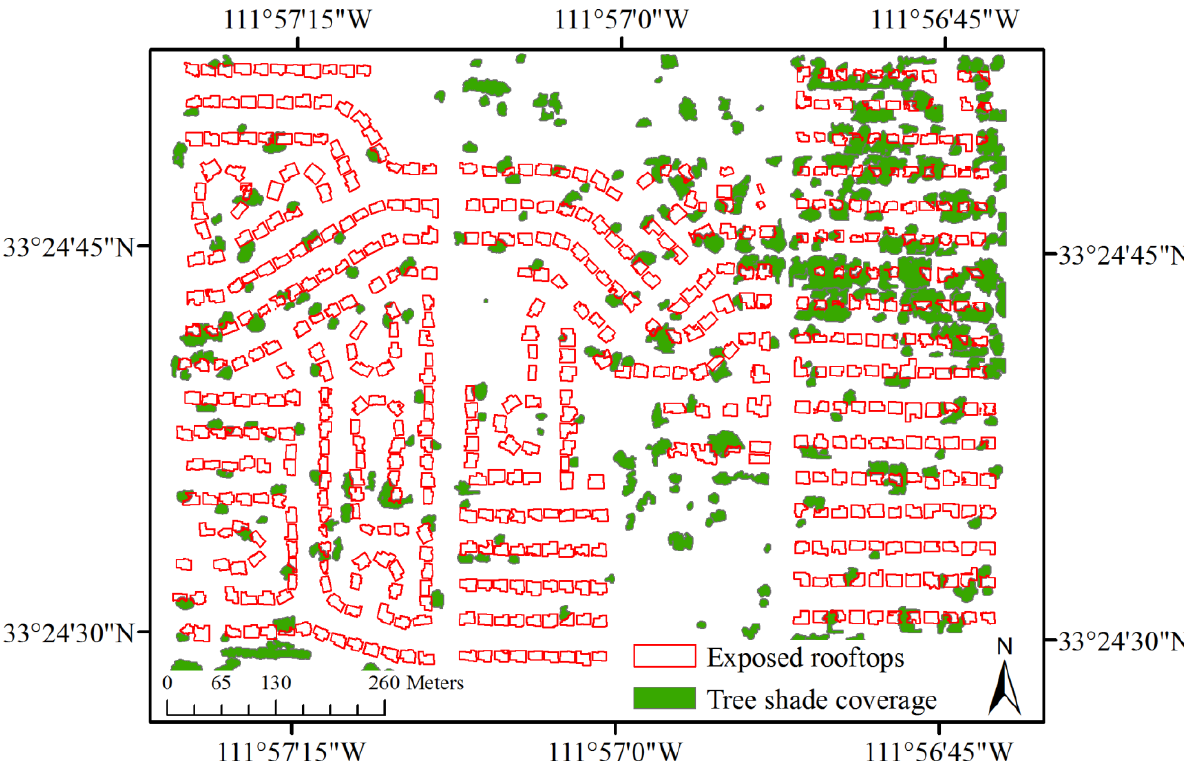
Figure 11. Tree shade.